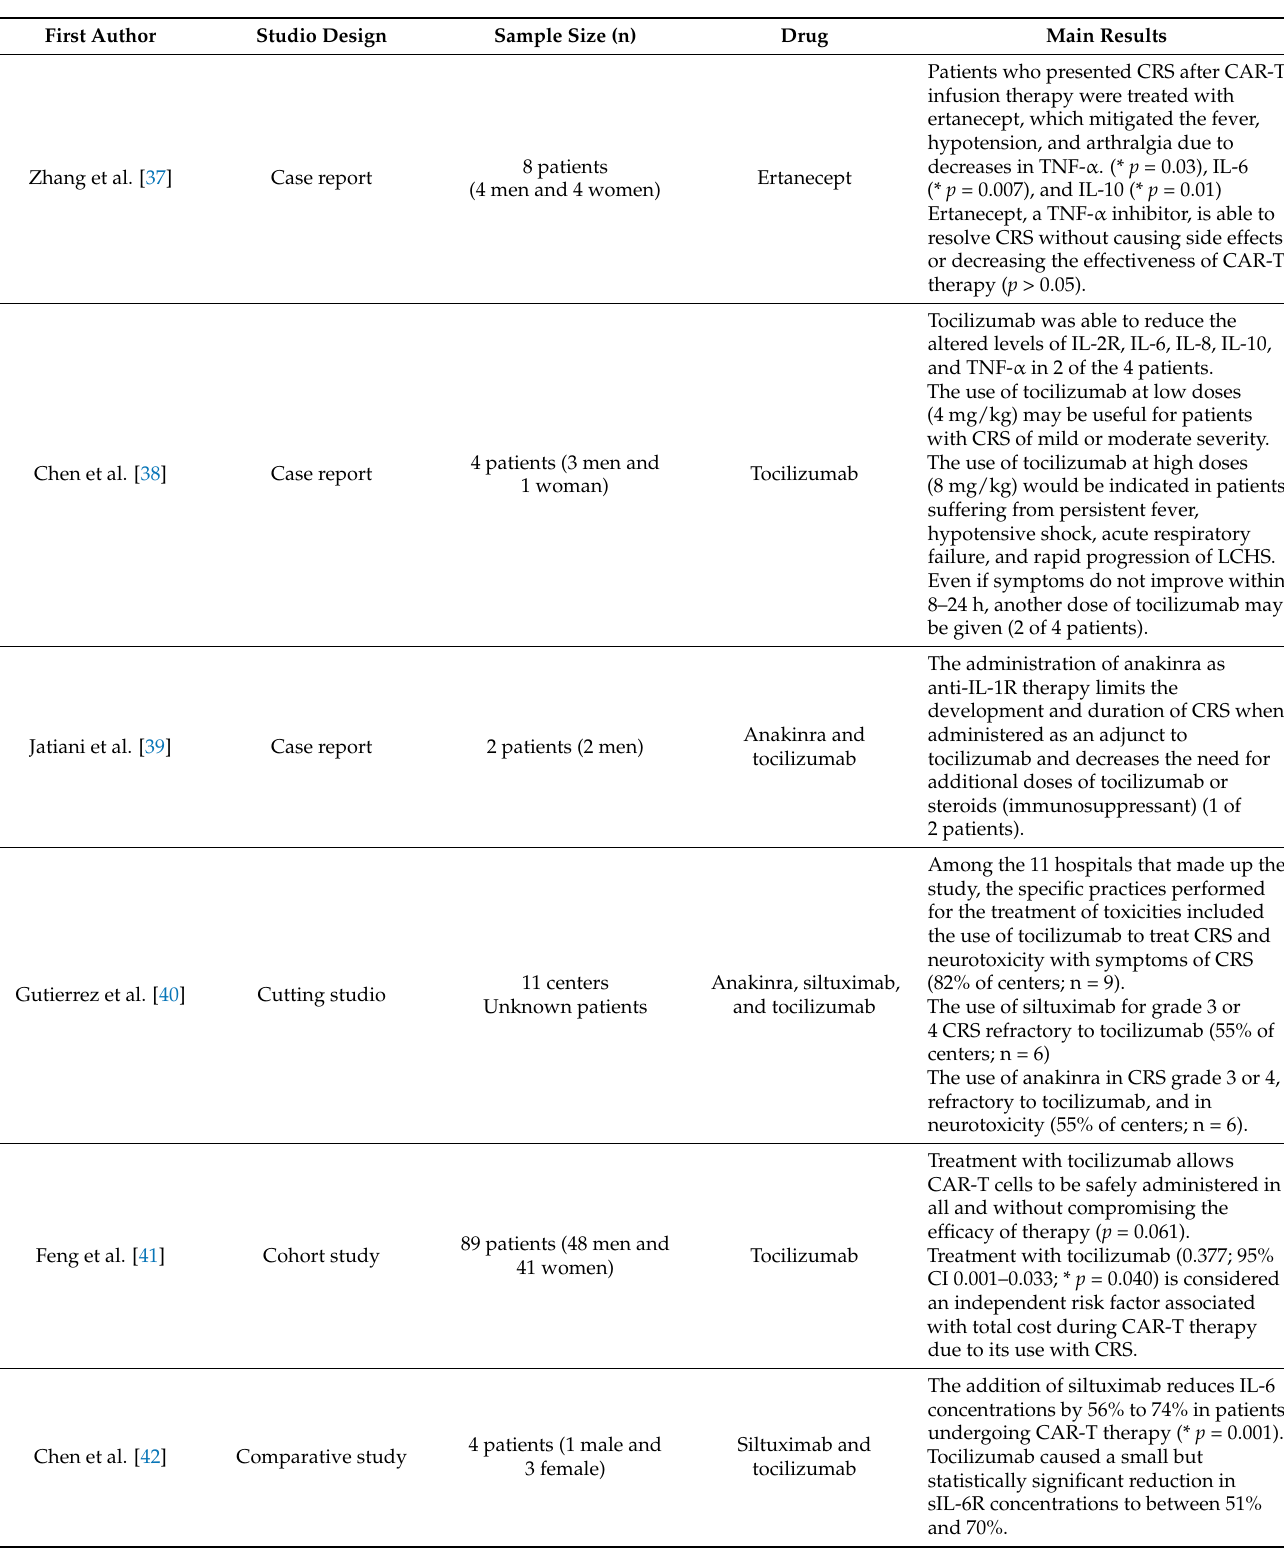
Table 1. Summary of the results obtained after the study of the